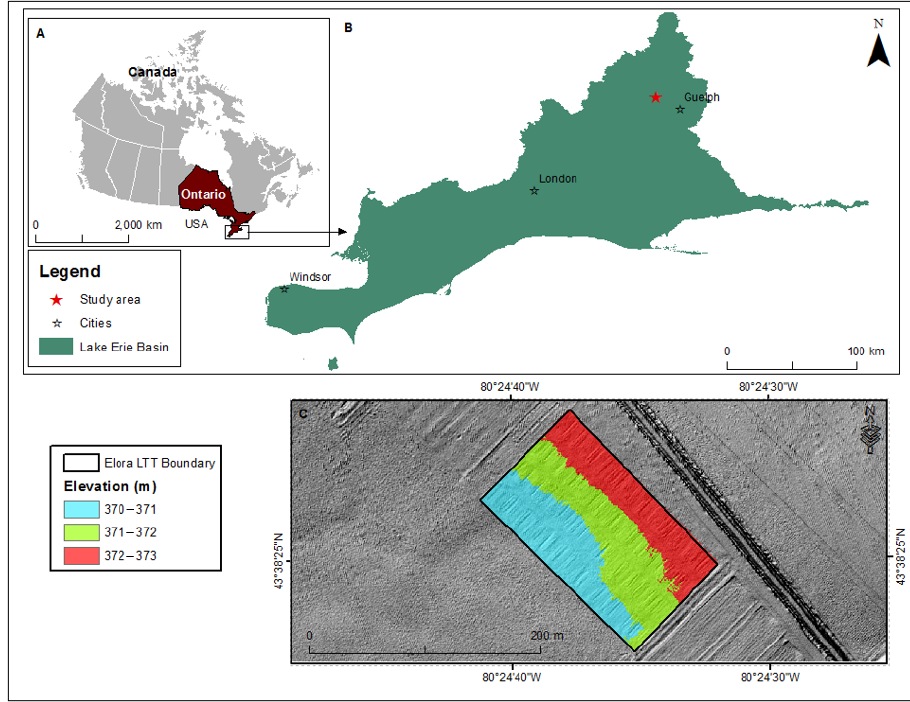
Figure 1. Location of the study site in southwestern Ontario (A) within the Lake Erie Basin (B). Topography of the long-term crop rotation/tillage site (C).